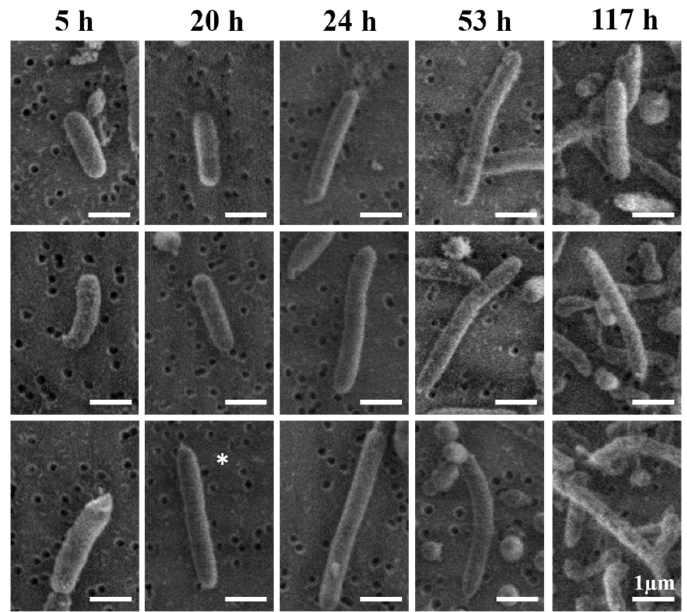
Figure 3. Emergence of the extended-rod morphology over the life cycle of V. fischeri . SEM images were acquired at five timepoints corresponding to the lag (5 h), exponential (20 h and 24 h), stationary (53 h), and death (117 h) phases (see Figure 1A). Panels at each timepoint illustrate that, starting from aspect ratios in the 3.5–4.0 range for normal adult individuals (ca. 2 µ m in length), increasingly higher aspect ratios are observed for extended-rod morphologies as a function of increasing growth time; * clear example of a “double-length” extended-rod morphology in the exponential phase (20 h).